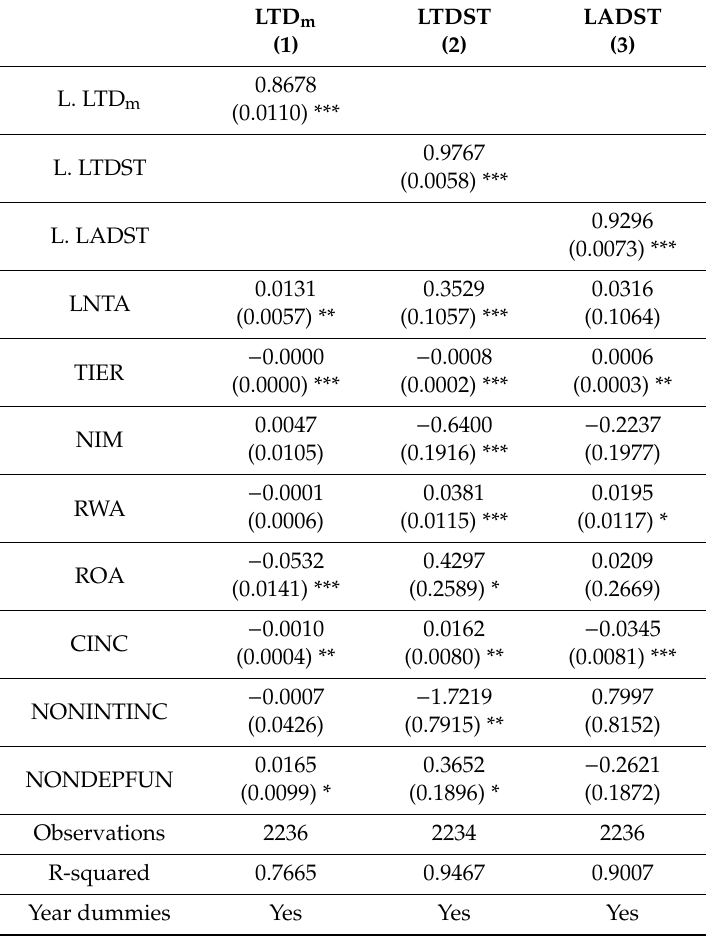
Table A3. Pooled dynamic